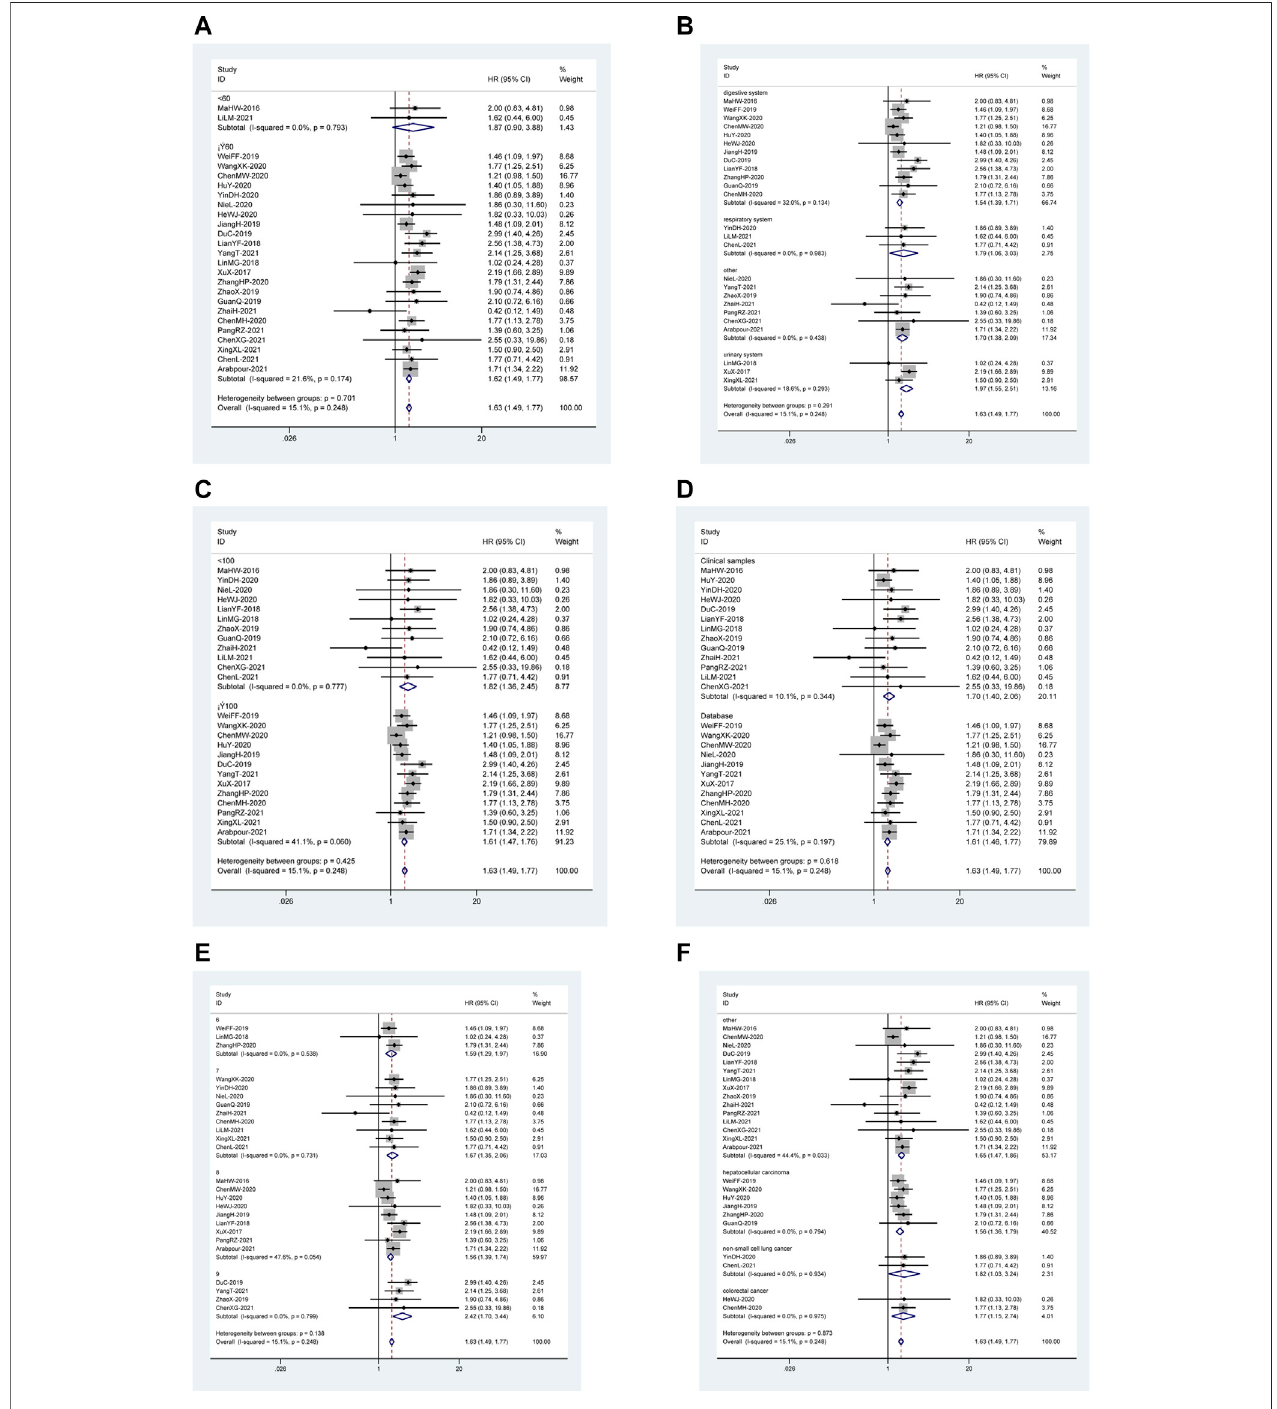
FIGURE 2 | Forest plot re fl ecting the association between OS and lncRNA DUXAP8 expression level in cancer. (A) : Subgroup analysis strati fi ed by follow-up time. (B) : Subgroup analysis strati fi ed by the system of cancer. (C) : Subgroup analysis strati fi ed by sample size. (D) : Subgroup analysis strati fi ed by sample source. (E) : Subgroup analysis strati fi ed by NOS score. (F) : Subgroup analysis strati fi ed by type of cancer.